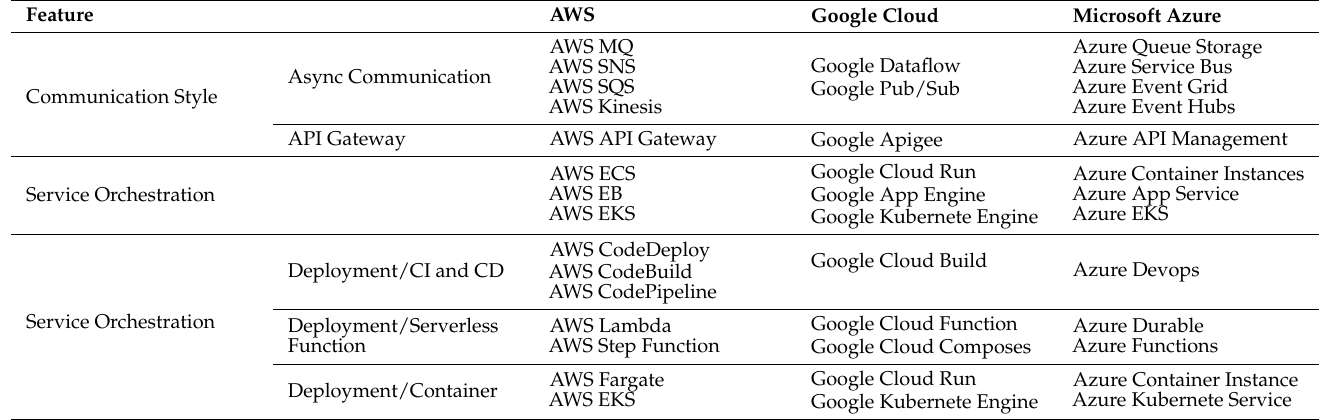
Table 3. Feature-based service comparison among AWS, Google Cloud, and Microsoft